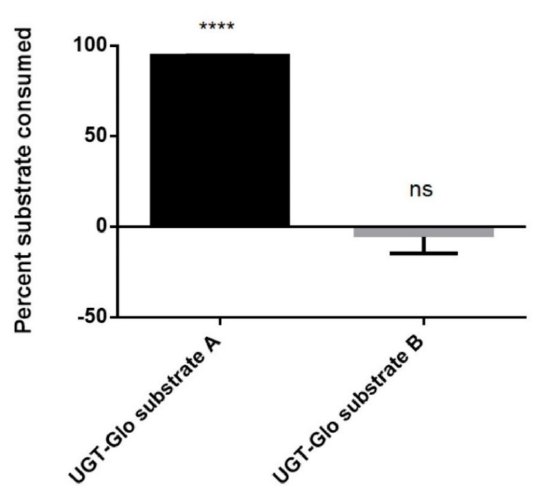
Figure2. Massspectrumof1-naphthylsulfateproducedfrom1-naphtholbyenzymebagbiotransformation Figure 2. Mass spectrum of 1-naphthyl sulfate produced from 1-naphthol by enzyme bag biotransformation with human SULT4A1 (C 10 H 8 O 4 S, [M–H] – theor. = 223.00705, [M–H] – exp. = withhumanSULT4A1(C 10 H 8 O 4 S,[M–H] – theor. = 223.00705, [M–H] – exp. = 223.00610, ∆ m / z = 4.26 ppm). 223.00610, Δ m /z = 4.26 ppm).